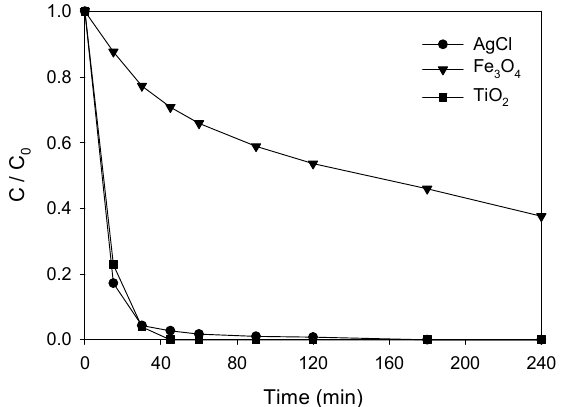
Figure 9. Comparison of nanocatalysts (0.75 g·L − 1 ) in the photocatalytic degradation of ATL (10 ppm) in aqueous solutions.